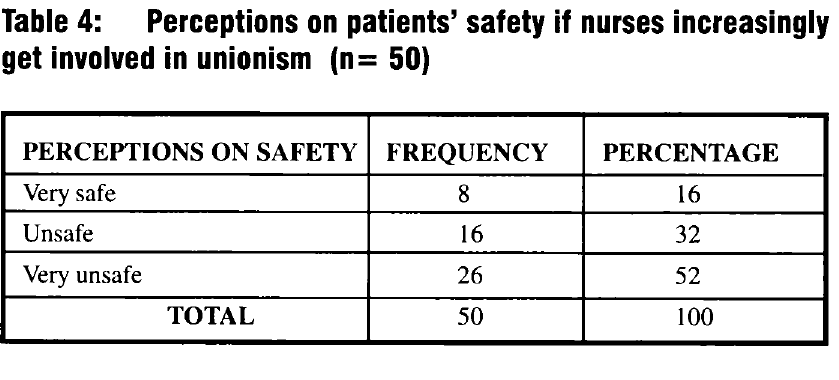
Table 4: Perceptions on patients’ safety if nurses increasingly get involved in unionism (n =